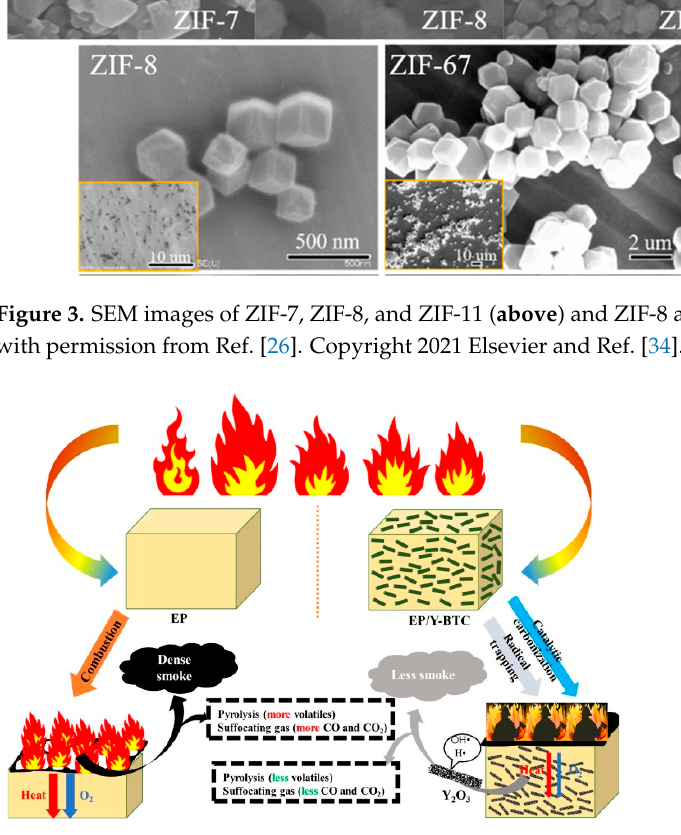
Figure 4. Schematic illustration of the proposed mechanism of EP/Y-BTC. Reprinted with permission from Ref. [44]. Copyright 2021, American Chemical Society.